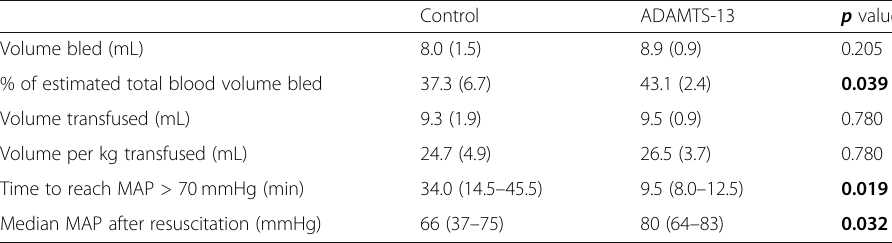
Table 2 Resuscitation Control ADAMTS-13 p value Volume bled (mL) 8.0 (1.5) 8.9 (0.9) 0.205 % of estimated total blood volume bled 37.3 (6.7) 43.1 (2.4) 0.039 Volume transfused (mL) 9.3 (1.9) 9.5 (0.9) Volume per kg transfused (mL) 24.7 (4.9) Time to reach MAP > 70 mmHg (min) 34.0 (14.5 –